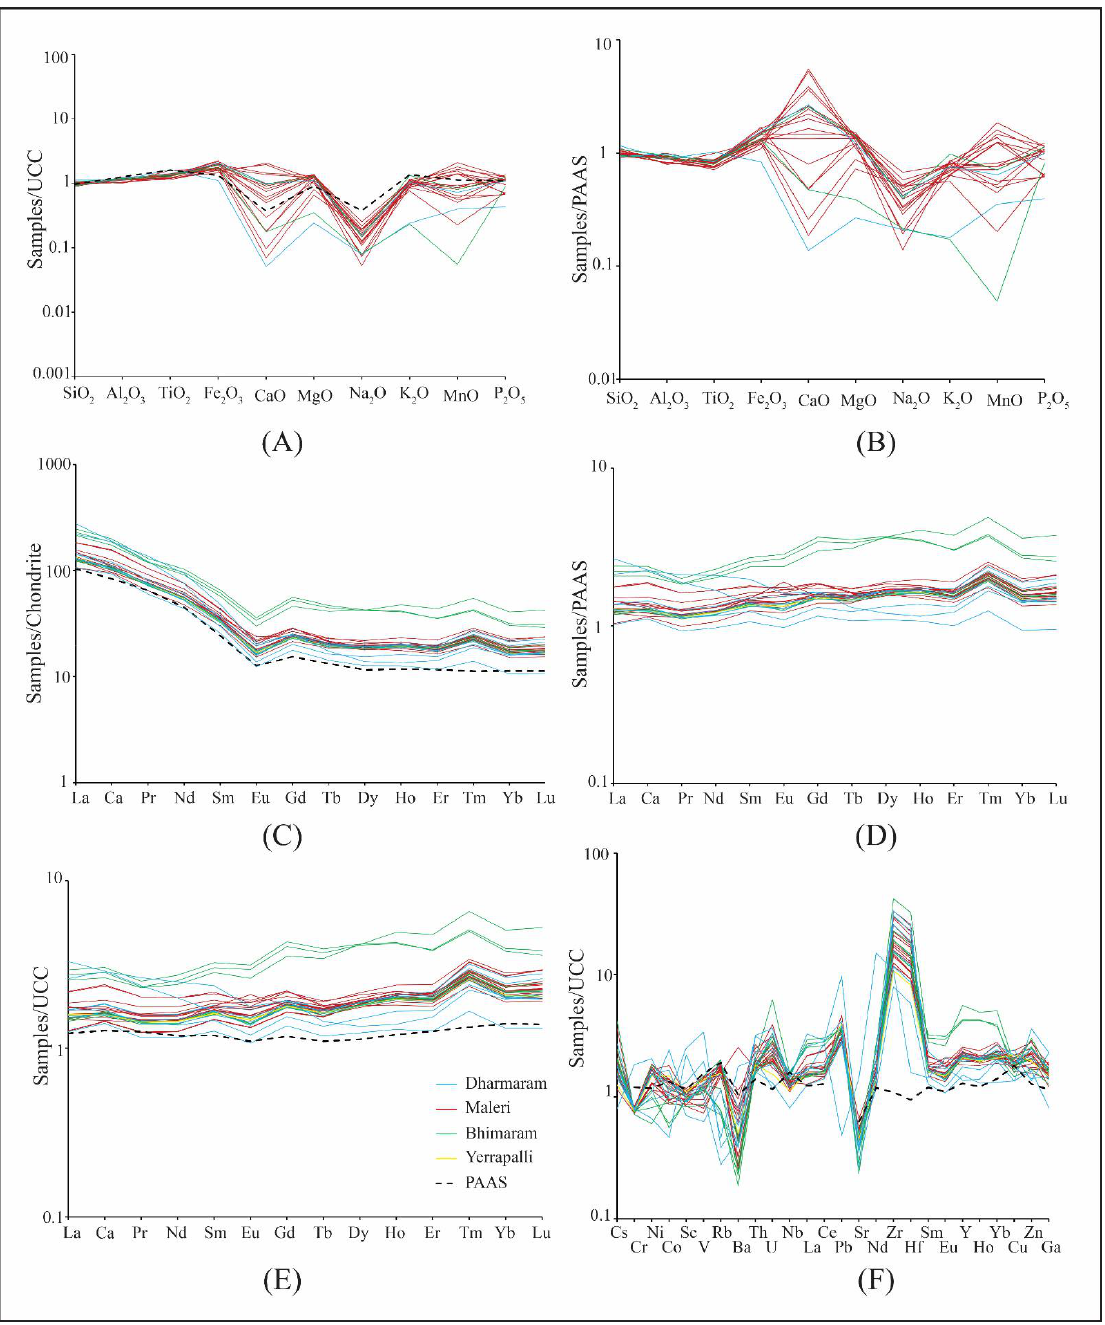
Figure 6. ( A ) Upper continental crust (UCC, [48])-normalized major element composition. ( B ) Post-Archean average Australian shale (PAAS, [47])-normalized major element composition. ( C ) Chondrite-normalized rare earth element (REE) plots for the Gondwana mudstone samples showing generally higher concentrations of light REE (LREE) than heavy REE (HREE), with a negative Eu-anomaly. Chondrite normalization values; REE compositions of PAAS (black dash line) are from [47]. ( D ) PAAS-normalized REE patterns showing positive values for both LREE and HREE. REE compositions of PAAS are from [47]. ( E ) UCC-normalized REE patterns showing uniform and positive pattern for both LREE and HREE. REE compositions for UCC are from [48]. ( F ) Spider plot of trace element compositions normalized against upper continental crust (UCC; [48]) for Gondwana mudstone samples. PAAS values are represented by the black dashed line [47].